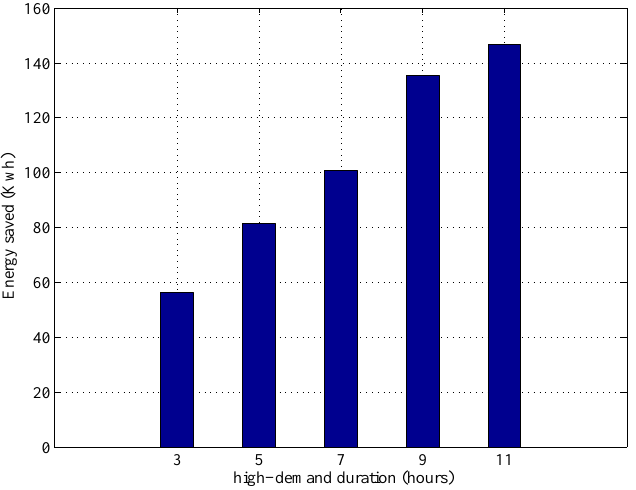
Figure 2. The amount of energy savings by running the Remote Appliances Control application.